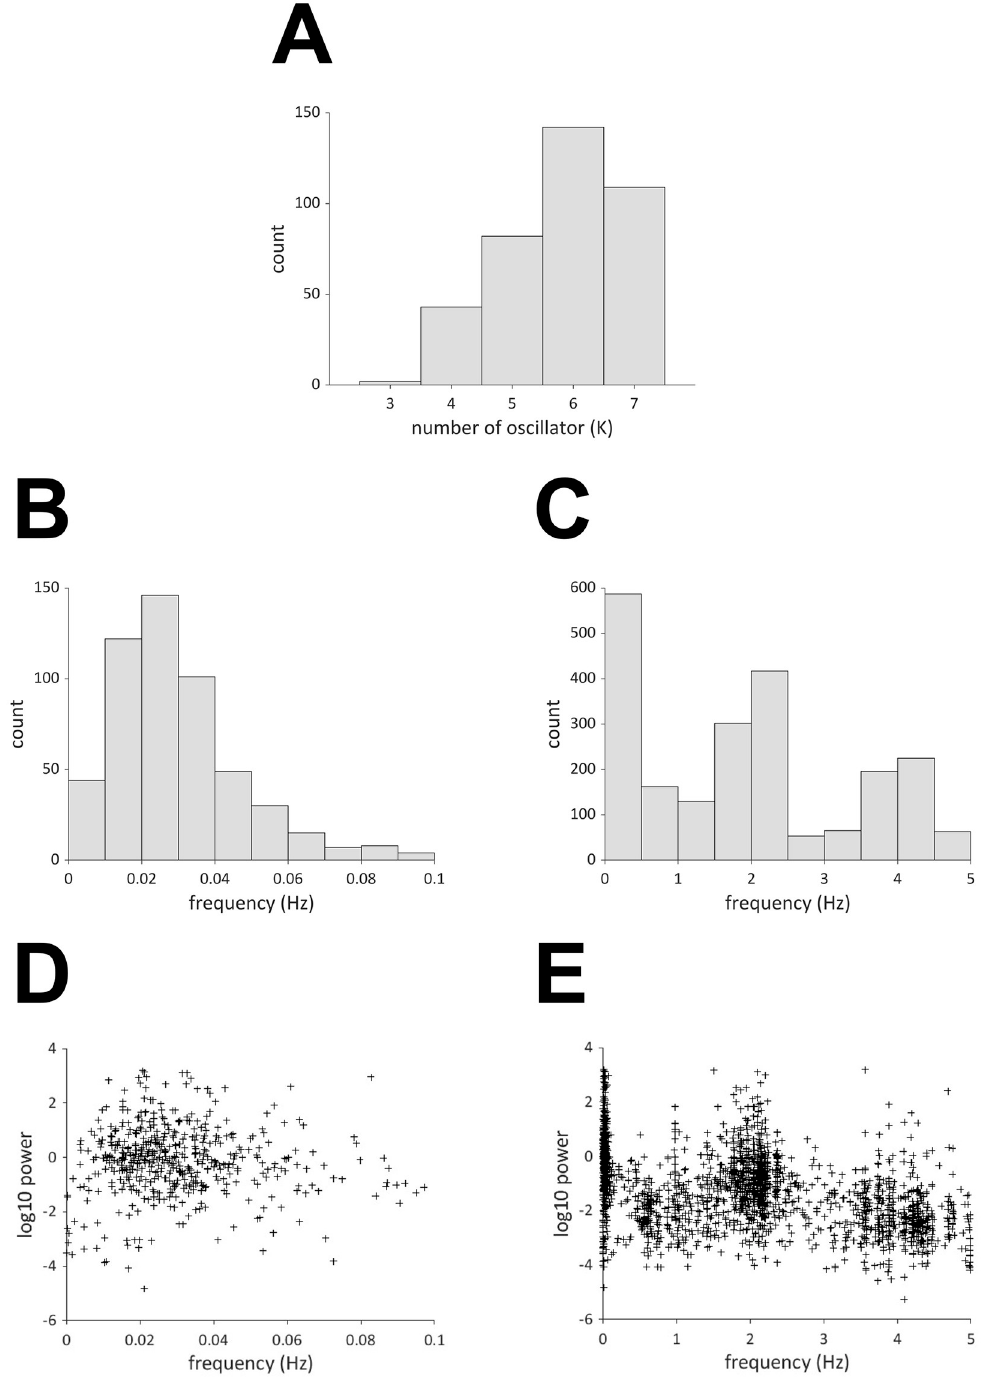
Fig 11. (A) Histogram of the number of extracted oscillators. (B) (C) Histogram of the frequency of extracted oscillators. (D) (E) Scatter plot of the frequency and power of the extracted oscillators.